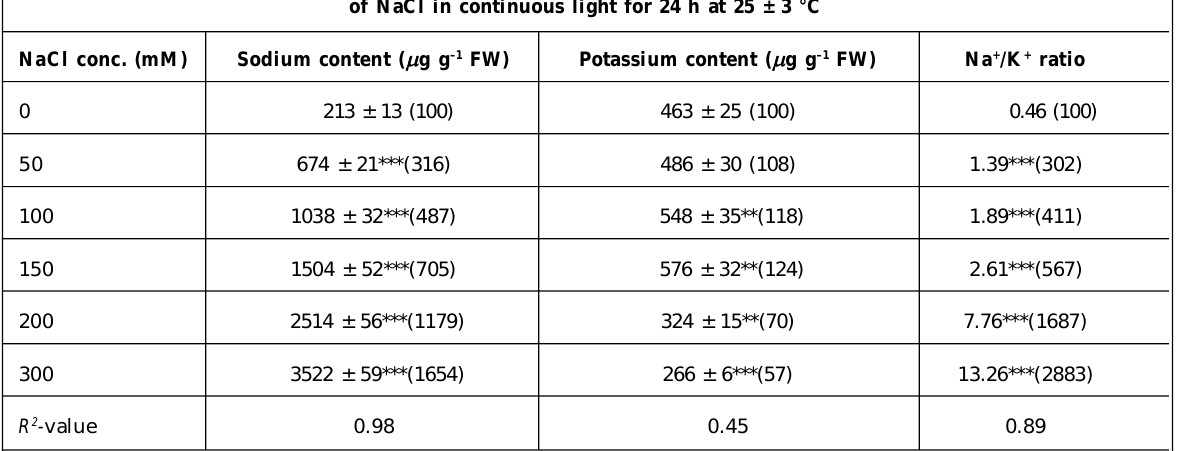
Table 2: Effect of salt stress imposed by using NaCl on Na + content, K + content and Na + /K + ratio in etiolated maize leaf segments during greening Leaf segments from dark grown maize seedlings were treated with varying concentrations of NaCl in continuous light for 24 h at 25 ± 3 °C NaCl conc.